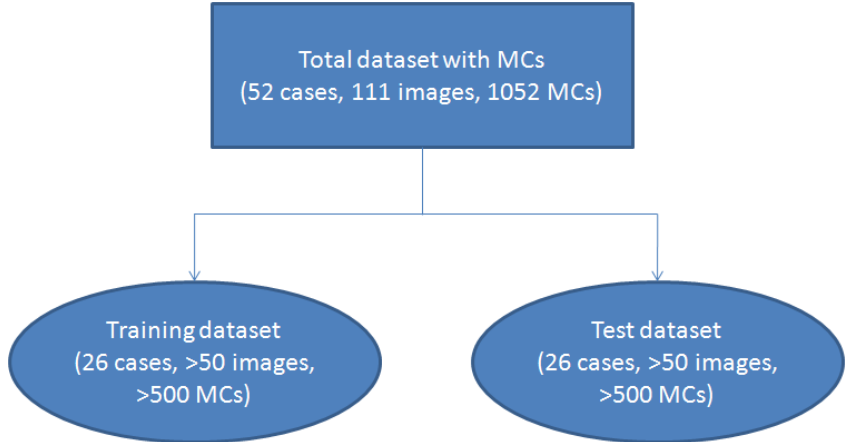
Figure 1. Two-fold cross-validation